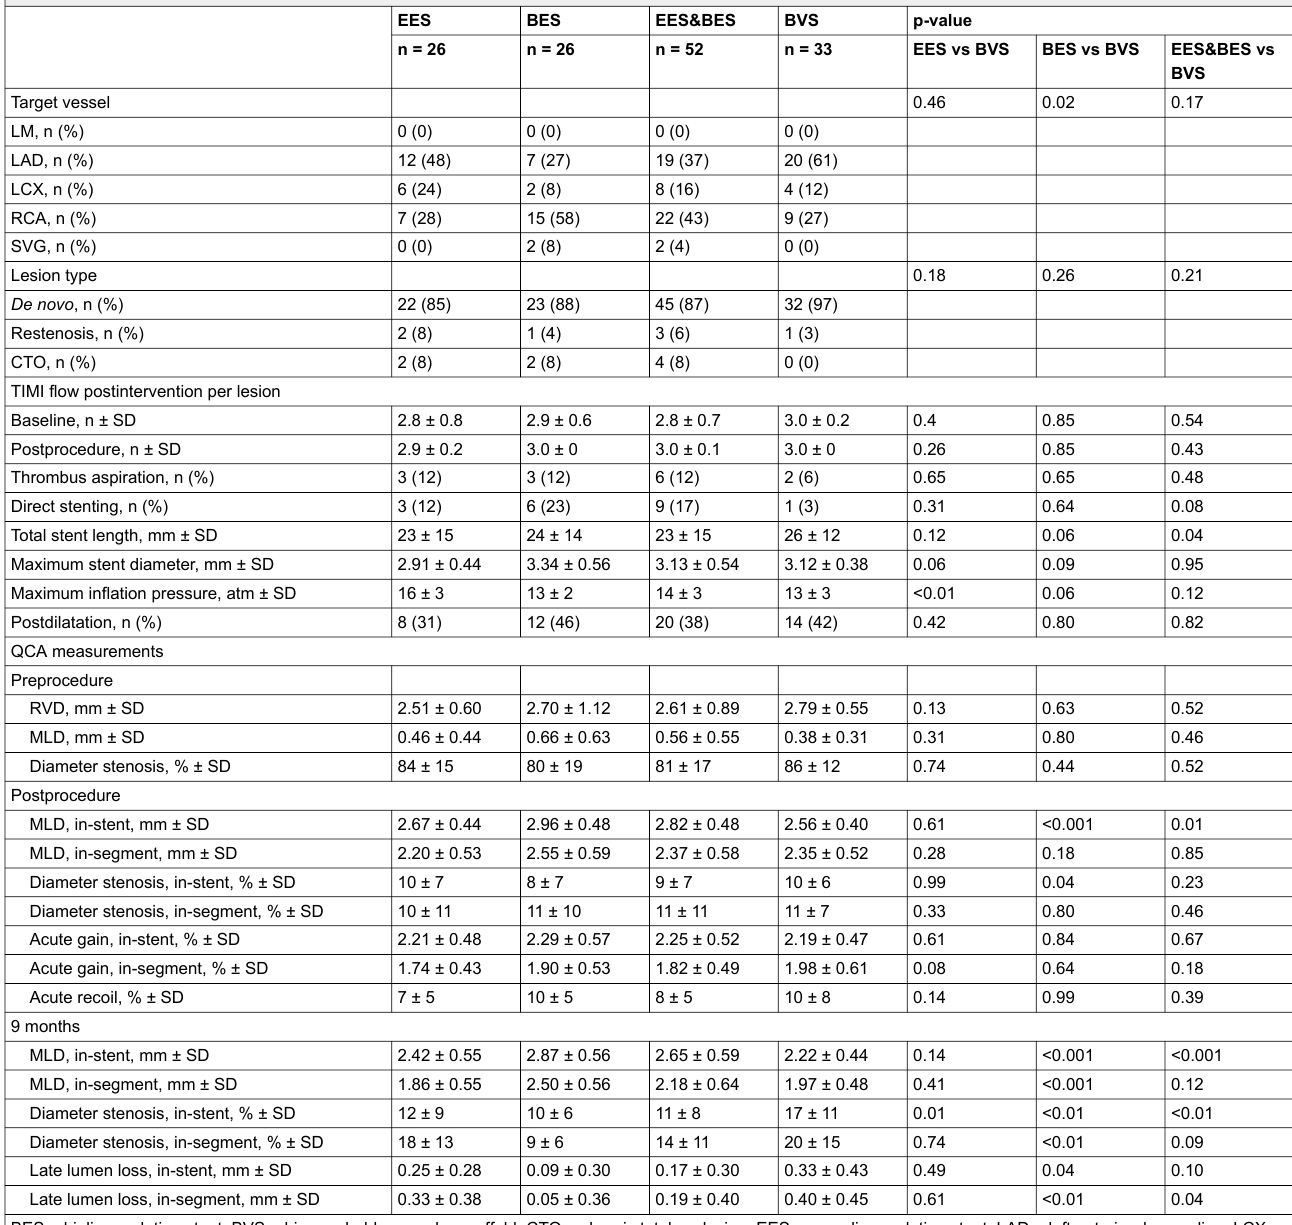
Table S2 : Procedural